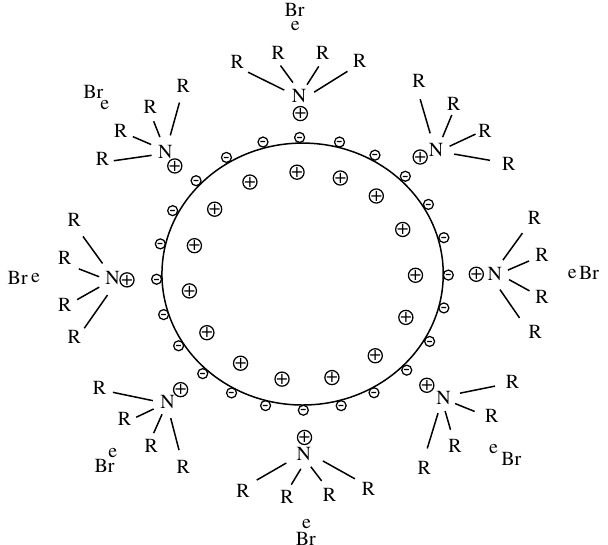
Figure 1. Schematic figure of a colloid 5